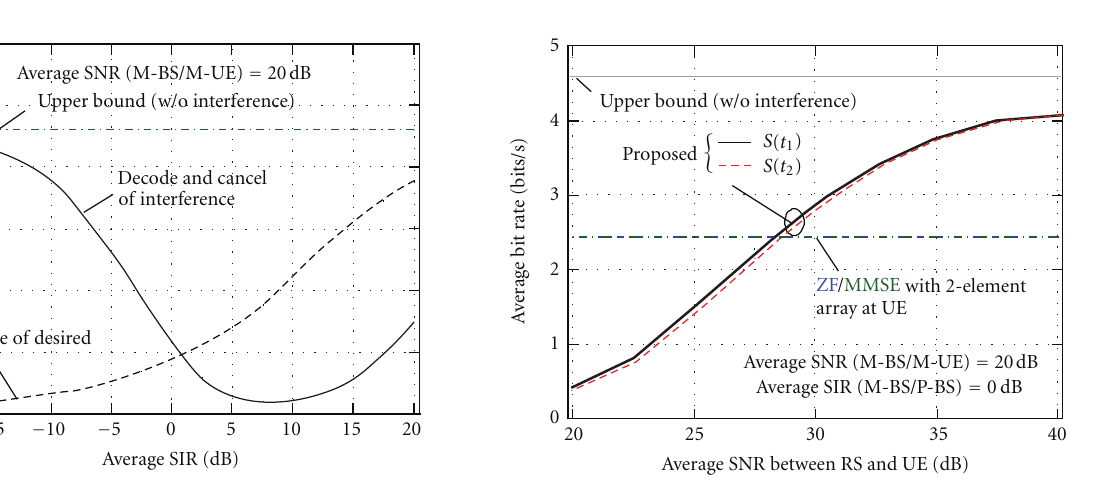
Figure 6: Transmission rate versus SIR. Figure 7: Transmission rate versus SNR between M-RS and